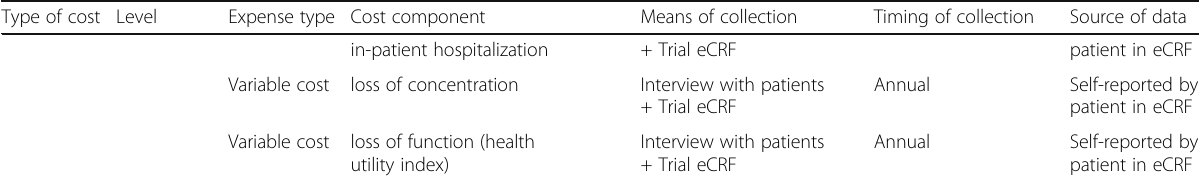
Table 2 Overview of cost measures (Continued) Type of cost Level